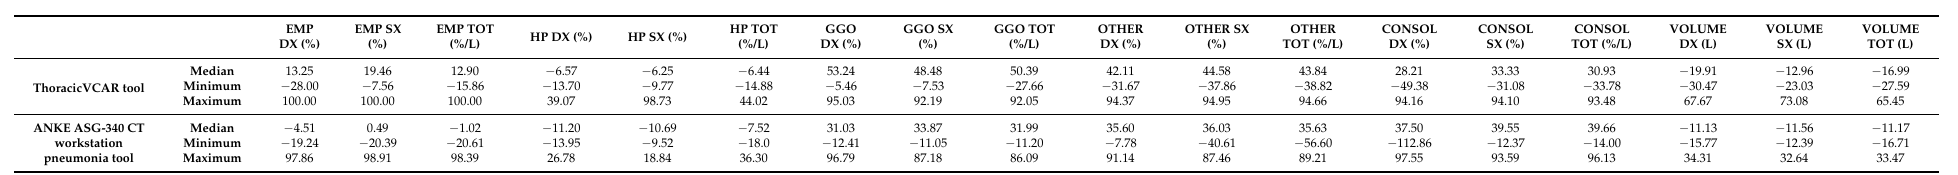
Table 7. Percentage change of quantified volumes by two tools between baseline and follow-up in patients with positive RT-PCR in terms of median, minimum, and maximum values.